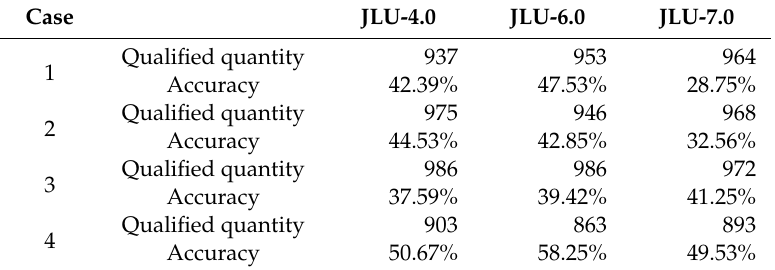
Table 13. The results of the quality evaluation and recognition of the four